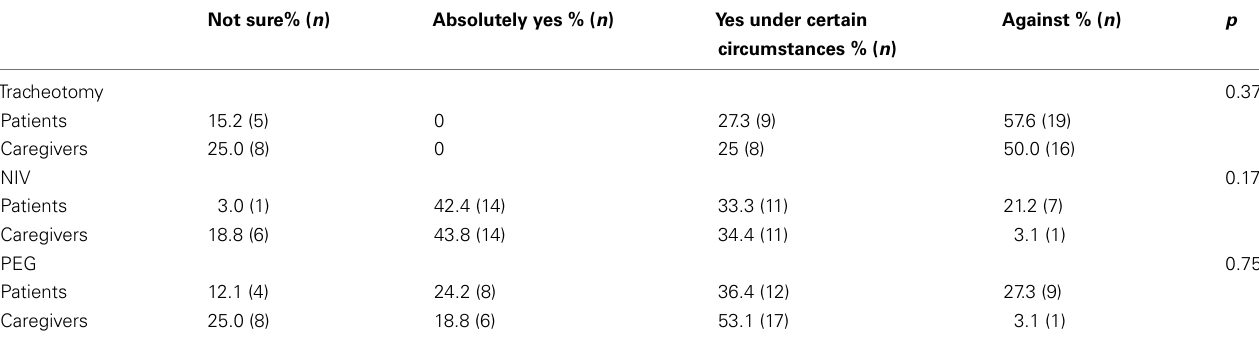
Table 3 | Live-prolonging measures: “what is your attitude toward the following life-prolonging measures?” p -values derived from McNemar test.